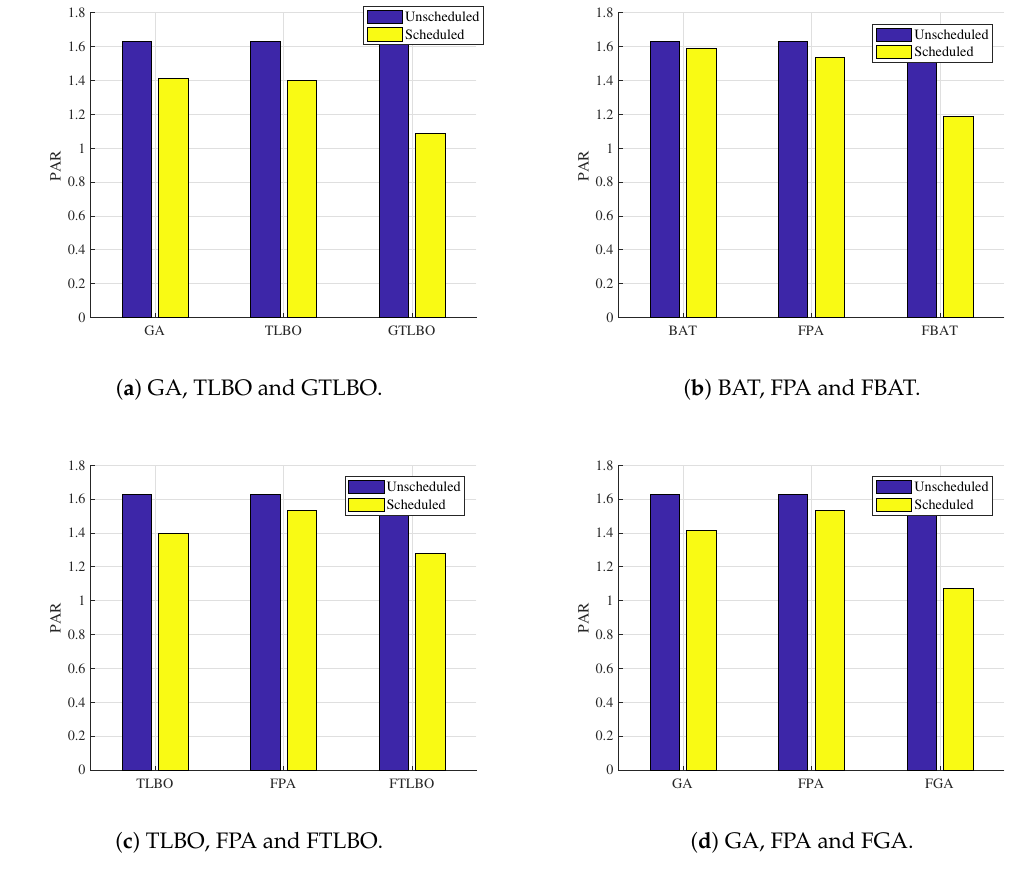
Figure 12. Daily discomfort of